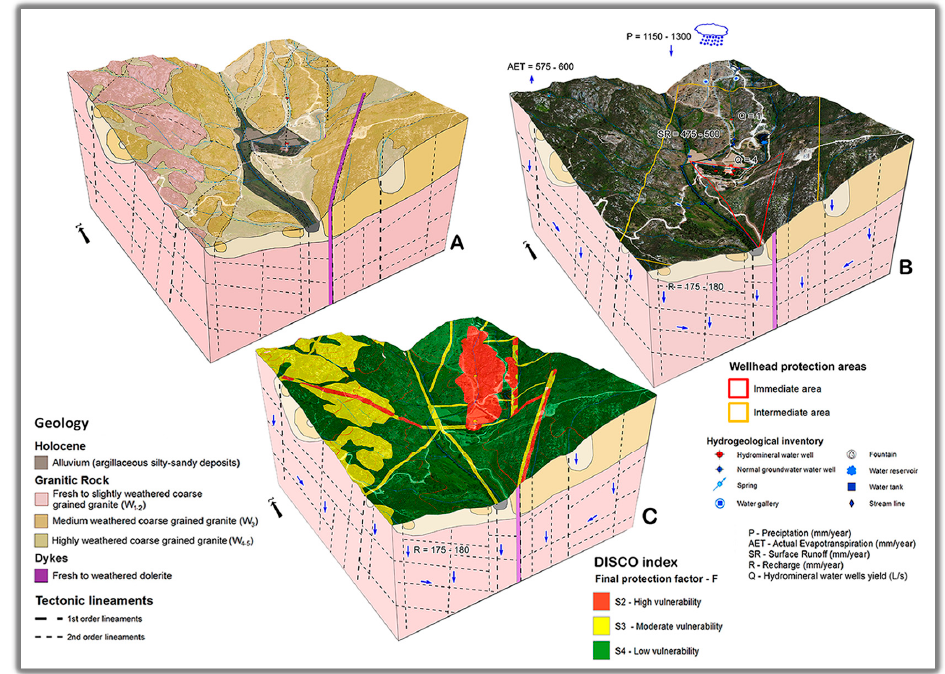
Figure 10. Hydrogeological conceptual model from the Caldas da Cavaca hydromineral system: